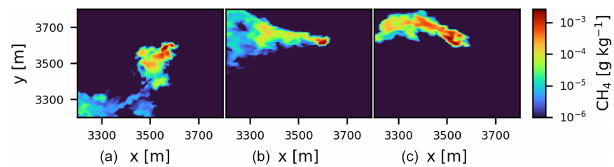
Figure 5. Snapshots of instantaneous plumes at 3m above the sur- face. Plume at (a) 11:30:00, (b) 12:15:00 and (c)